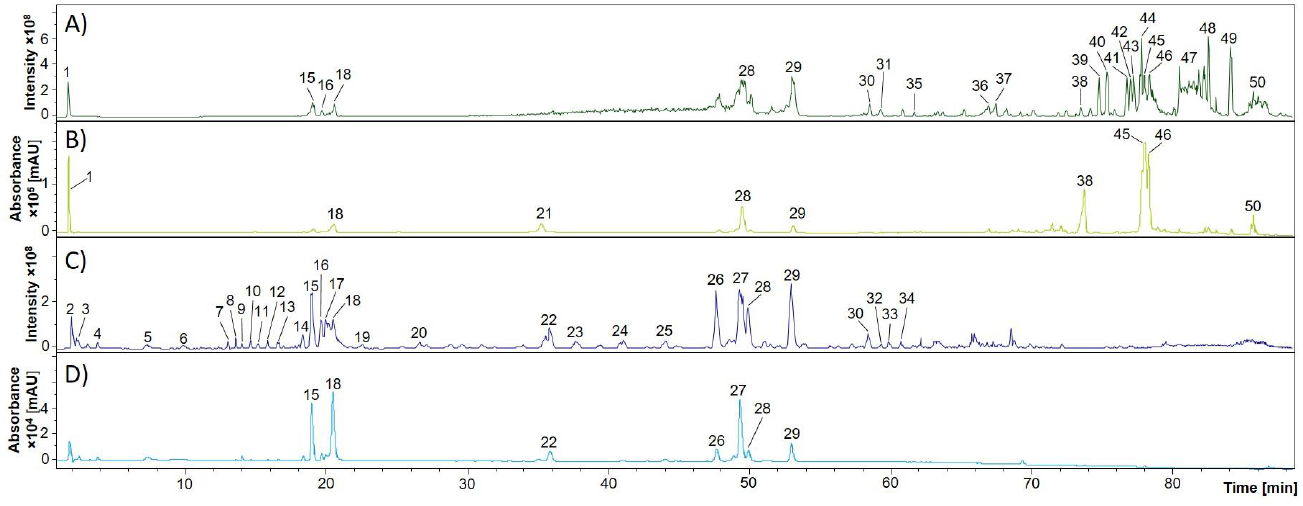
Figure 3. Secondary metabolites in root extracts of M. recutita analyzed via RP-HPLC-DAD-ESI-MS n . The peak numbering corresponds to Table 2. ( A ) Base peak chromatogram (BPC) of an ethyl acetate extract; ( B ) Corresponding UV chromatogram (200 – 600 nm); ( C ) BPC of an n -butanol extract; ( D ) Corresponding UV chromatogram (200 – 600 nm). Peak numbers refer to Table 2. Table 2. HPLC-DAD-MS n data of compounds detected in ethyl acetate and n -butanol extracts of M. recutita roots in negative ionization mode.